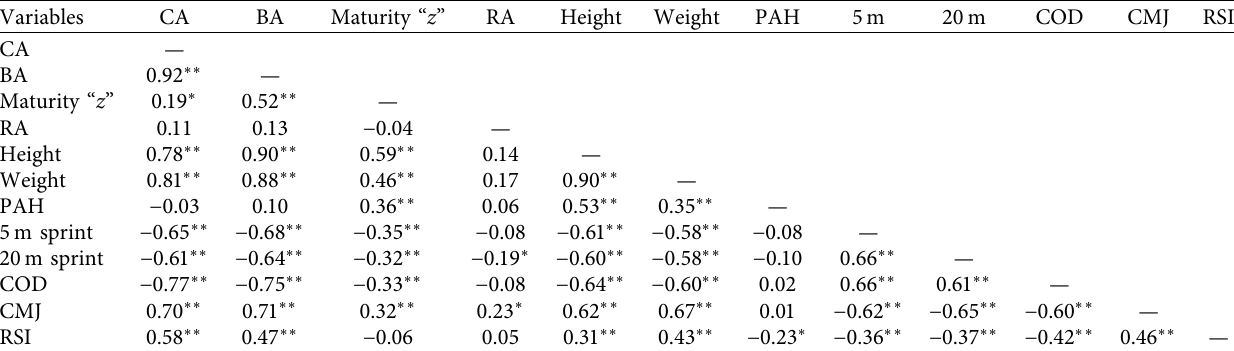
Table 2: R values for correlational analyses between various anthropometric, maturity, and fitness